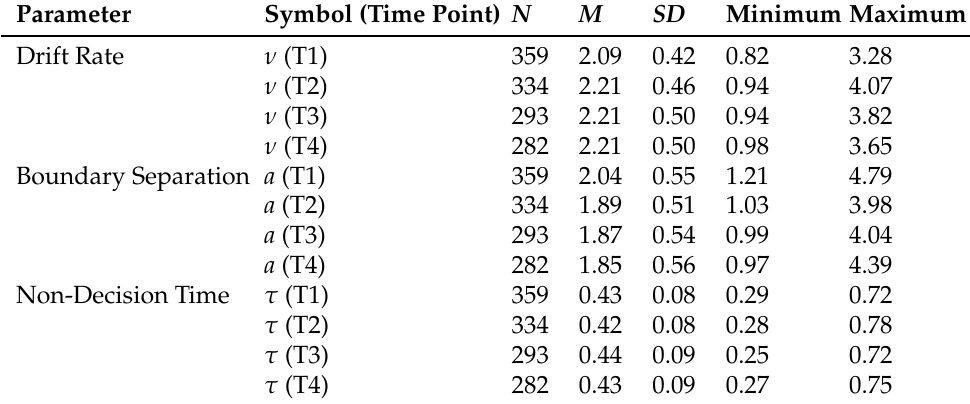
Table 1. Summary statistics of the individual posterior medians of diffusion model parameters for each time point across all